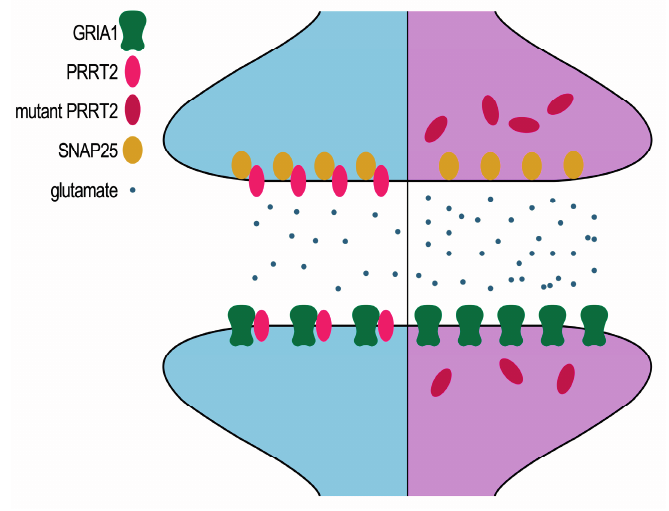
Figure 6. Schematic representation of mutant PRRT2 affecting the glutamate signaling